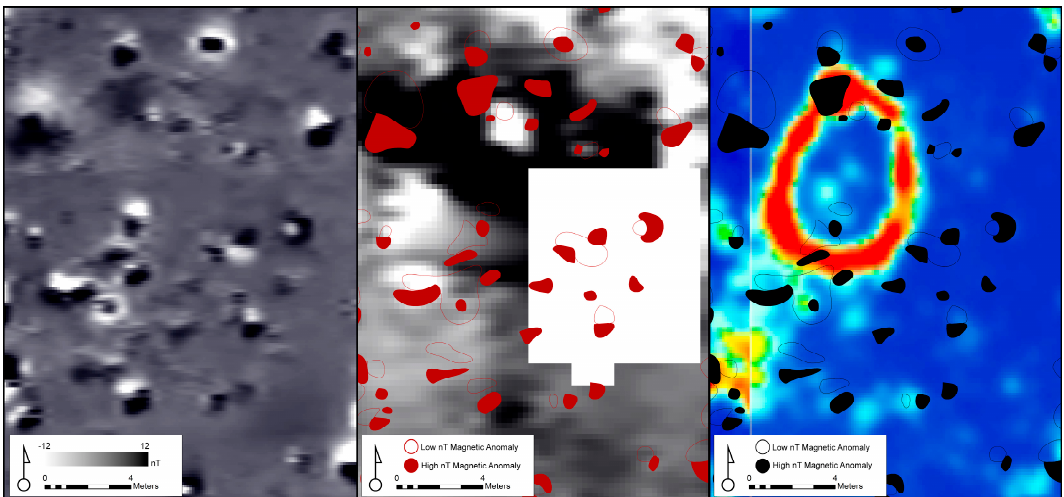
Figure 21. Magnetic gradiometry ( left ), electrical resistivity ( center ), and GPR ( right ) maps showing anomalies that may represent the remains of the house of Pedro Menéndez de Avilés.